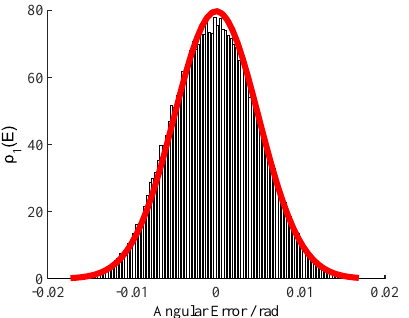
Figure 18. The angular error PDF of single closed-loop.